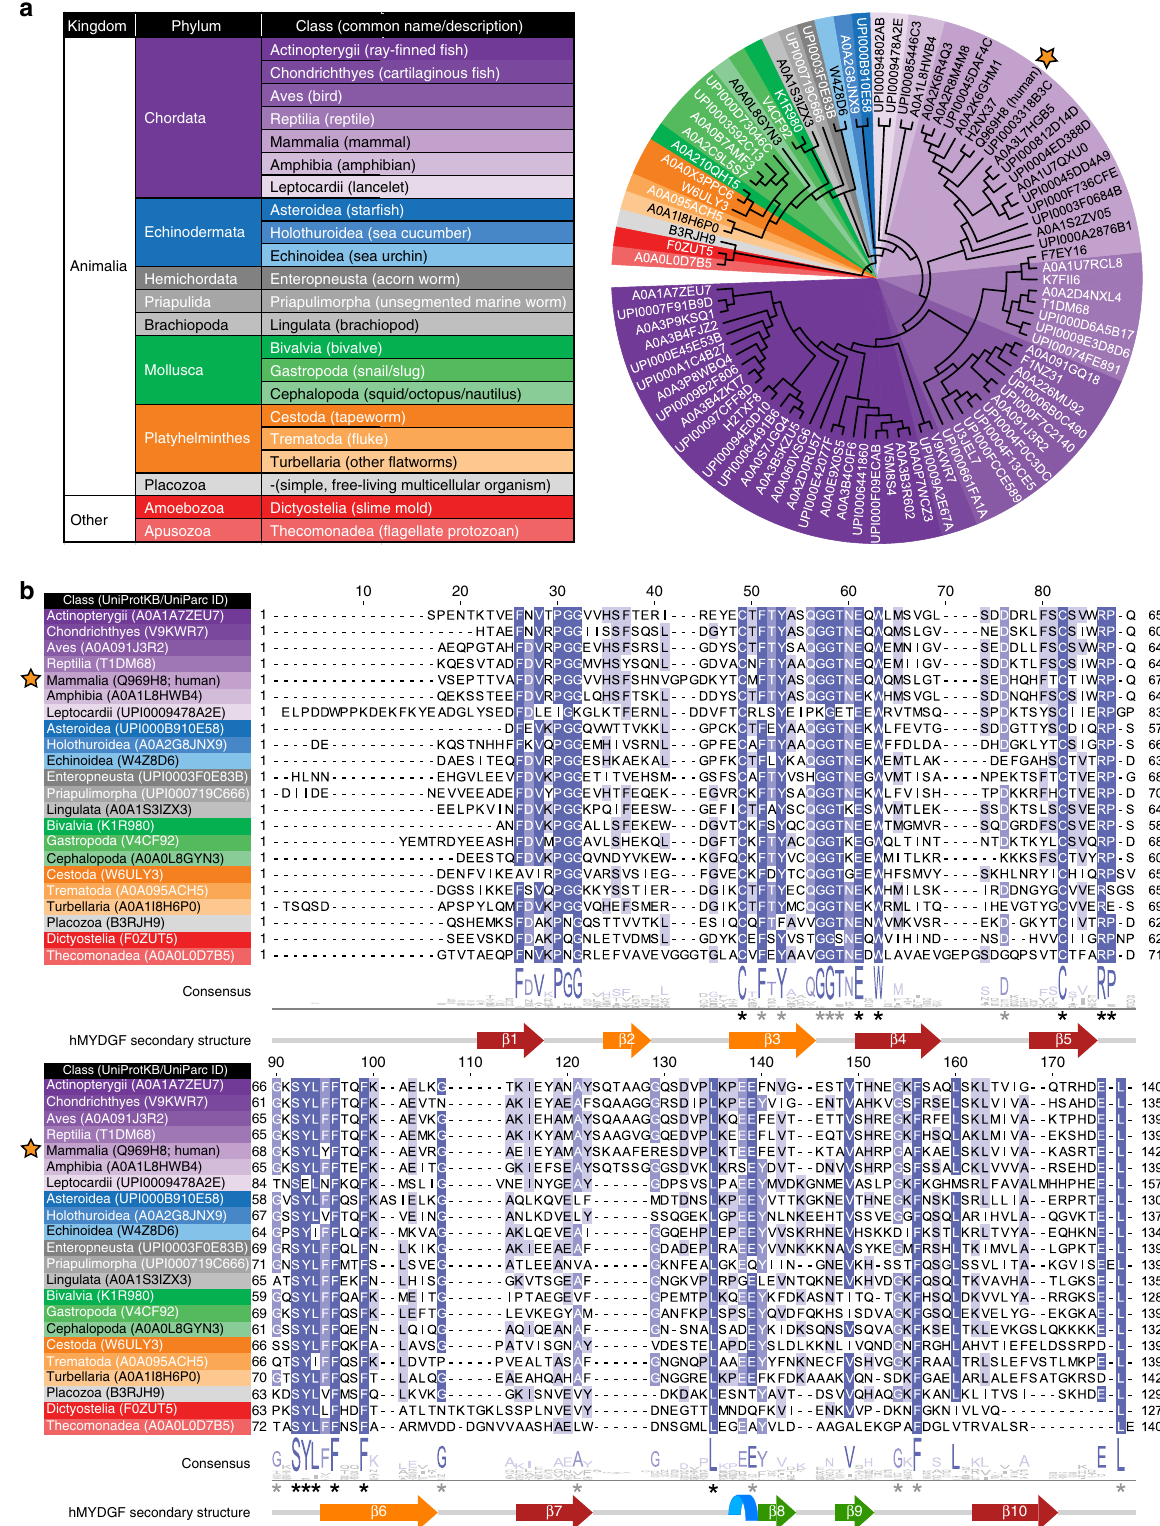
Fig. 4 Homologs of hMYDGF. a Phylogenetic tree color-coded by phylum and class of 87 MYDGF homologs identi fi ed by ConSurf in the UniRef90 database using the amino acid sequence of hMYDGF lacking its signal sequence (star) as the query. b Protein sequence alignment of MYDGF homologs from each of the classes in a with hMYDGF secondary structure displayed underneath. Asterisks represent highly conserved residues among all 236 UniProt90 MYDGF sequences identi fi ed by BLAST (black, ≥ 90% identity; gray, ≥ 85%